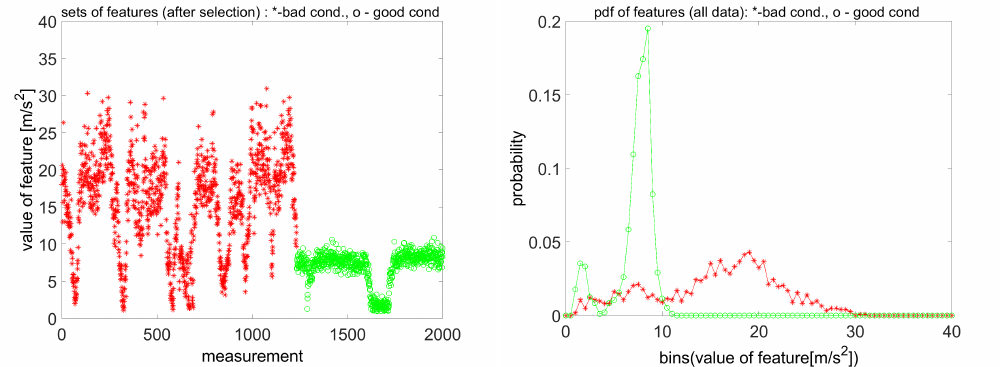
Figure 4. Aggregated feature series for bad and good conditions ( left ) and Histograms of good and bad condition data (right )